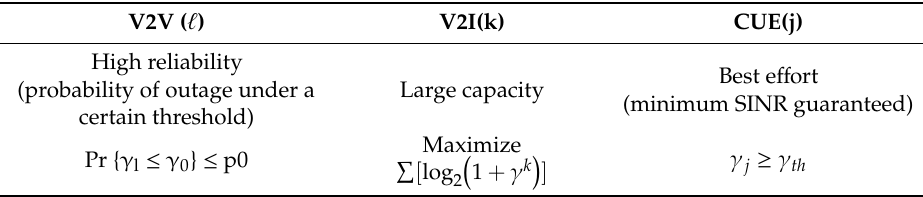
Table 1. Requirements for different user equipment (UE).